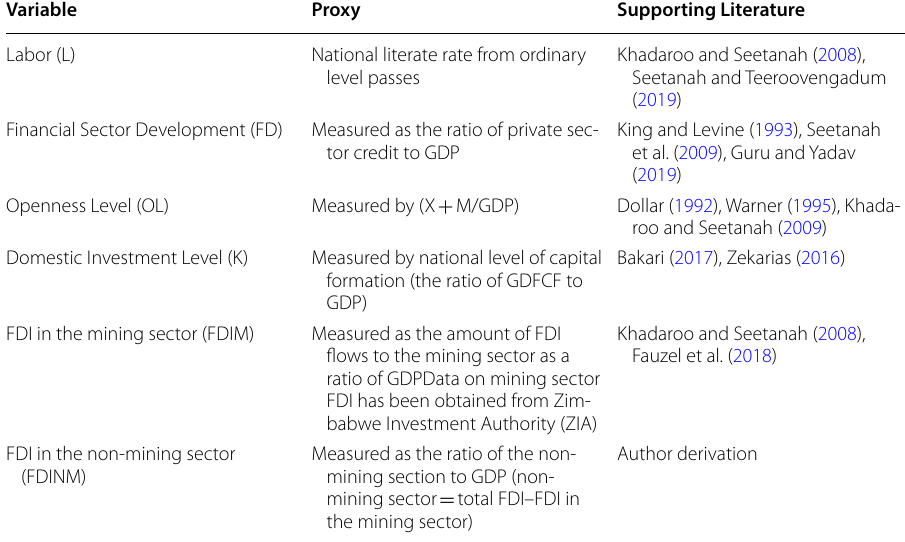
Table 1 Summary of variables